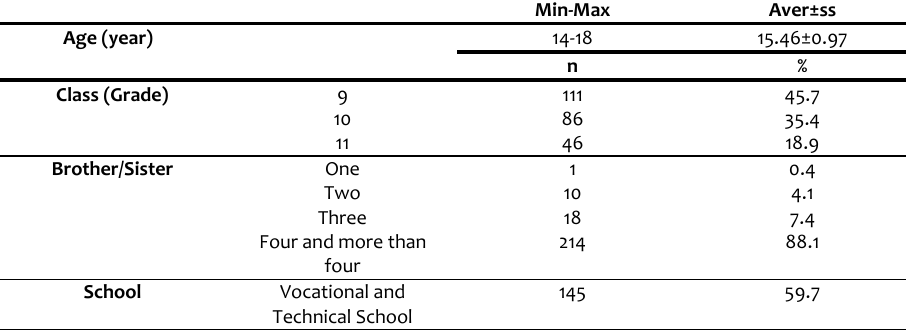
Table 1. Demographical Distribution of